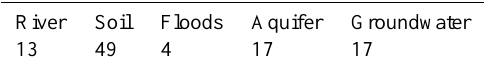
Table 6. Contribution of the reservoirs for the configuration AQ-F forced by TRMM